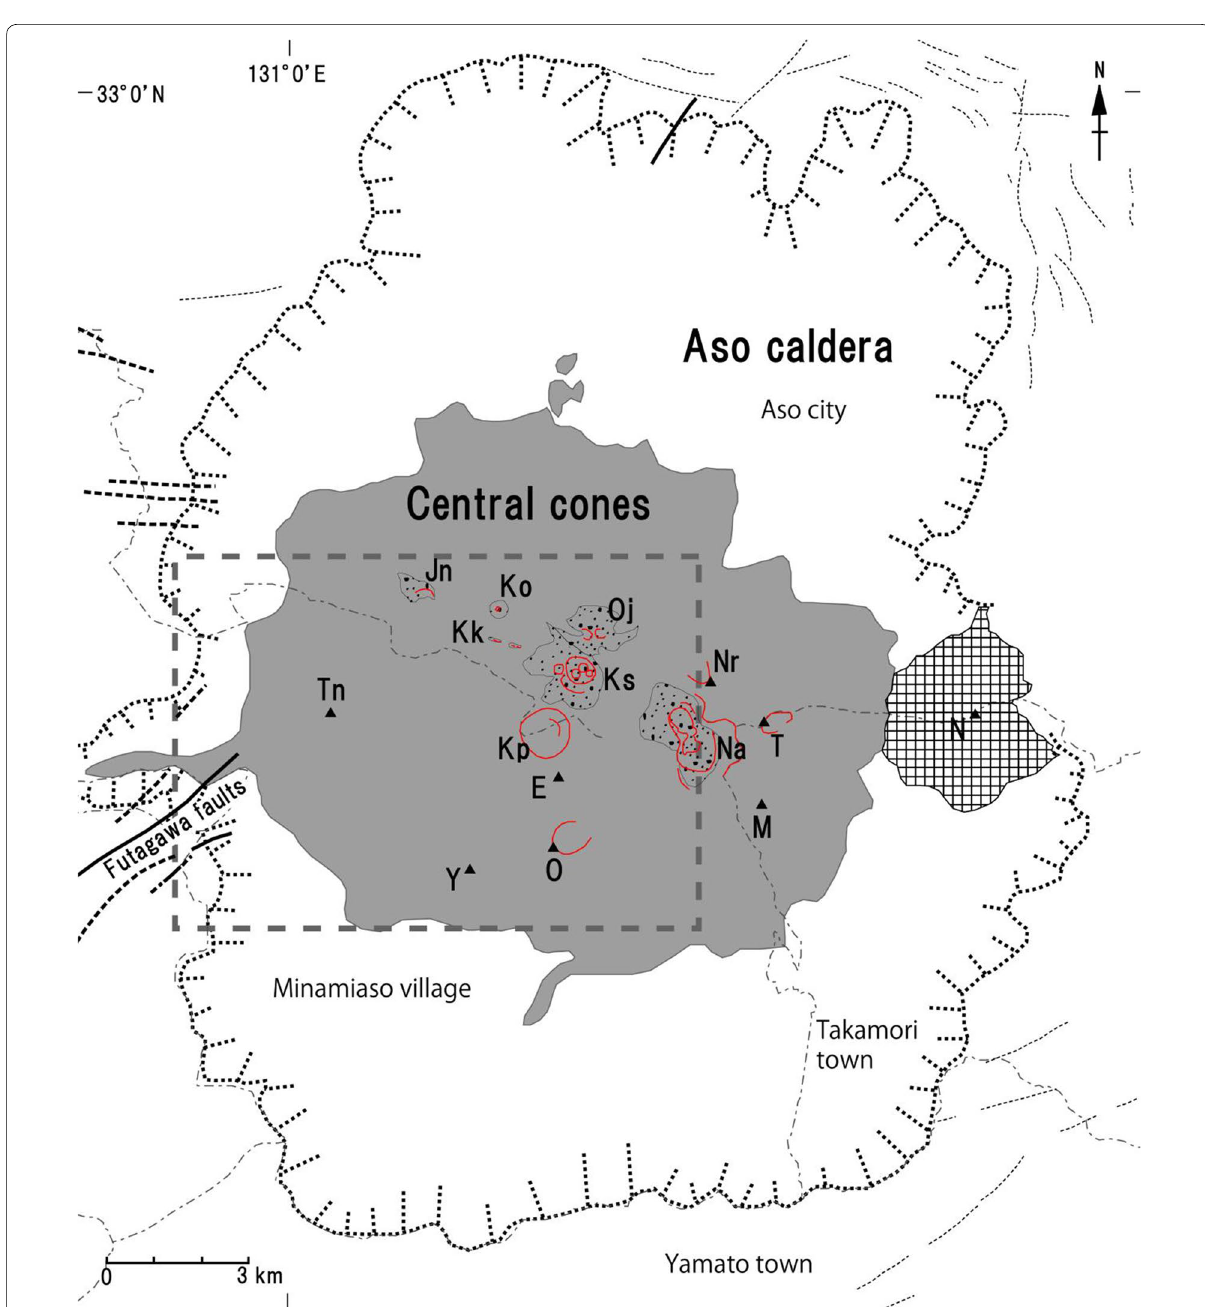
Fig. 1 Index map of Aso volcano. Red lines denote volcanic craters; dots represent areas of volcanic cones; bold lines and dashed lines denote observed and estimated active faults, respectively; and the fine dashed lines denote the lineaments. The bold dashed square represents the study area. This map was created following Ono and Watanabe (1985). Jn, Janoo scoria cone; Ko, Komezuka volcano; Kk, Kamikomezuka scoria cone; Oj, Ojodake volcano; Ks, Kishimadake volcano; Na, Nakadake volcano; Nr, Naraodake volcano; T, Takadake volcano; M, Maruyama volcano; Kp, Kusasen- rigahama volcano; E, Eboshidake volcano; O, Okamadoyama volcano; Y, Yomineyama volcano; Tn, Takanoobane volcano; N, Nekodake